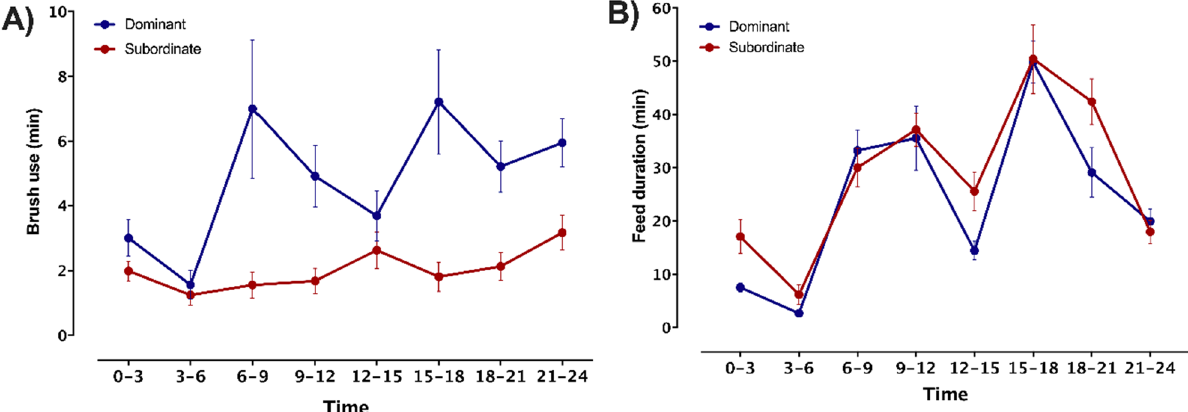
Figure 2. Mean brush use time ( A ) and time spent at the feed bunk ( B ) during 3-h periods of the day for dominant (n = 12) and subordinate (n = 12) cows during the week before